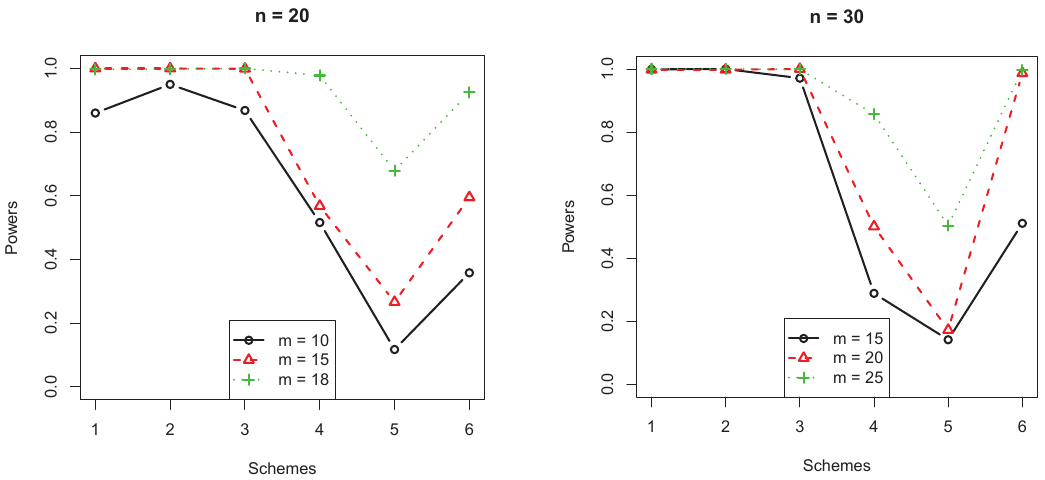
Figure 3. Powers of different schemes for the monotone increasing hazard function Bathtub-shaped(15) for the ˆCRKL test, in the case of n = 20 and